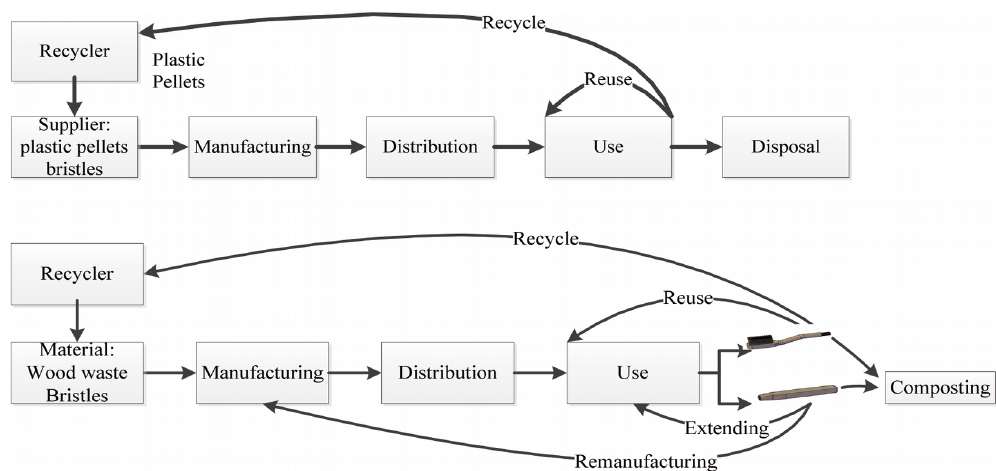
Figure 2. Cycling and extending strategy on waste wood